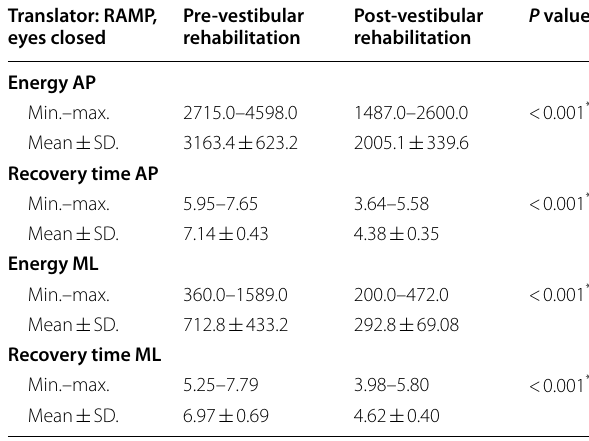
Table 13 Translator: RAMP, eyes closed scores in pre- and post-